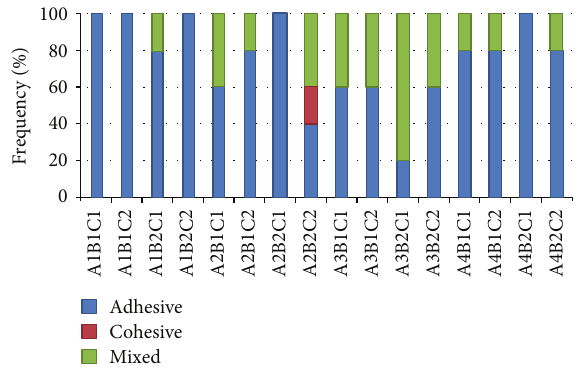
Figure 6: Different failure modes for all groups.